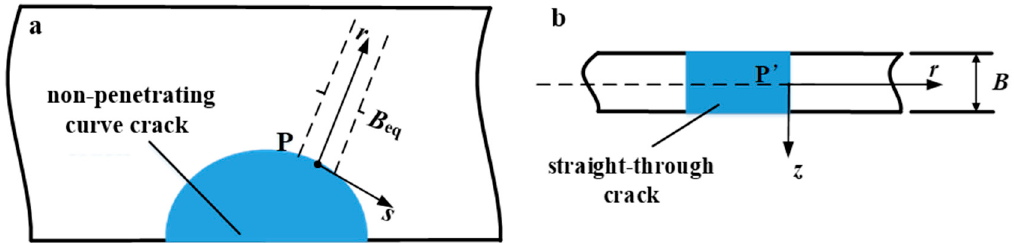
Figure 4. ( a , b ) Schematic diagram of equivalent thickness. Figure 4. Schematic diagram of equivalent thickness.